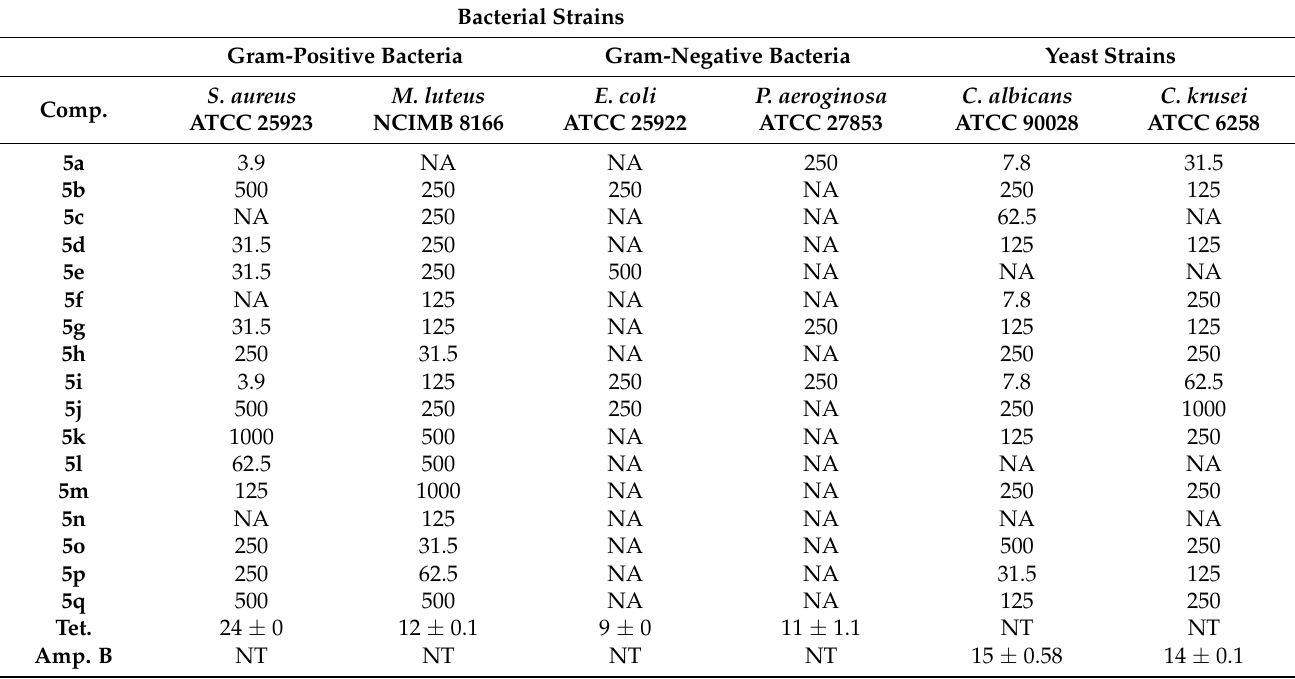
Table 4. Antibacterial and antifungal activity (MIC in µ g/mL). Bacterial